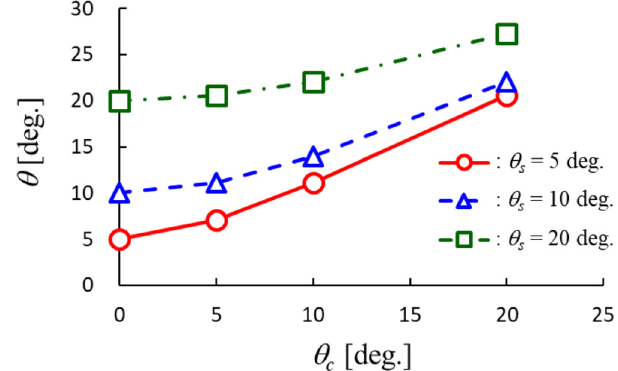
Fig. 9. In fl uence of u s and u c on u .